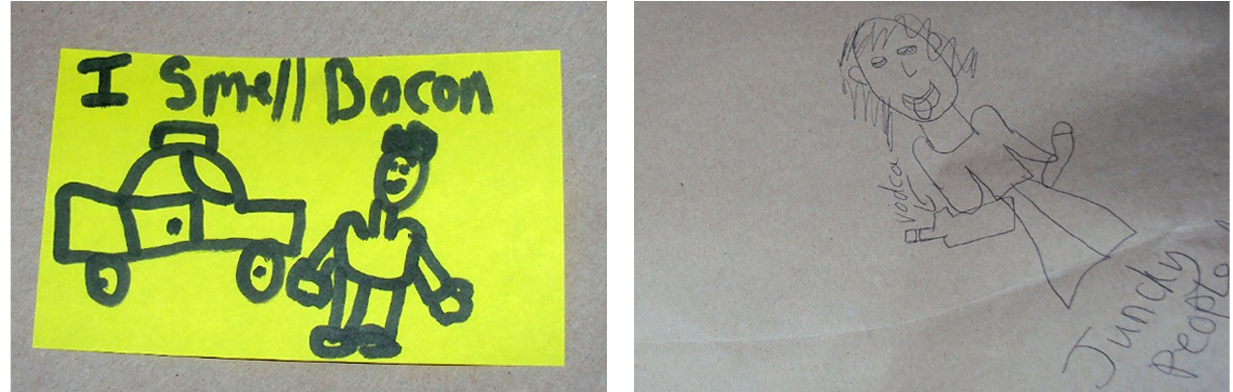
Figure 1. Marginalia produced during group mapping